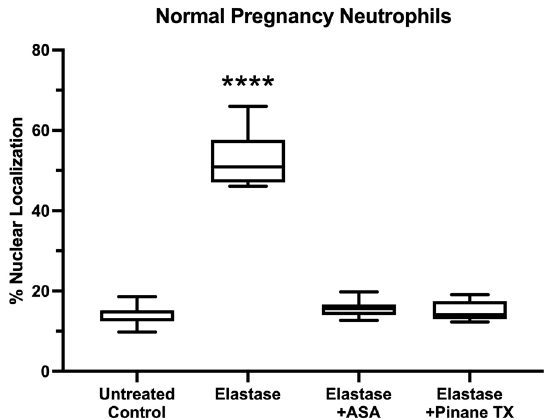
Figure 2. Percent nuclear localization of p65. ( n = 11, **** p < 0.0001; ASA, aspirin).